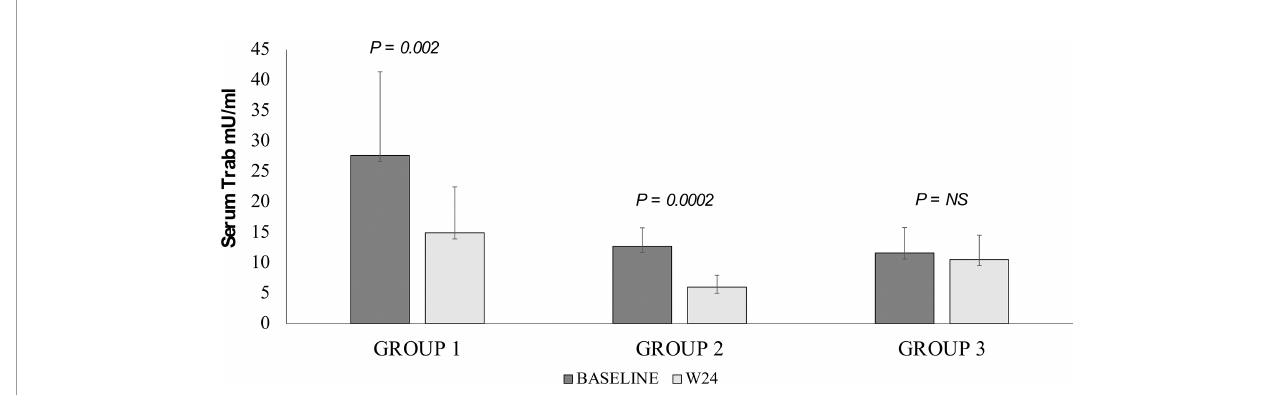
FIGURE 4 | Changes of serum TRH receptor antibody levels at 24 weeks in patients with GO treated with different doses of RTX. Group 1 = 100 mg; Group 2 = 500 mg; group 3 = 1000 mg x 2. Baseline values are in dark grey and values at 24 weeks in light grey. Paired